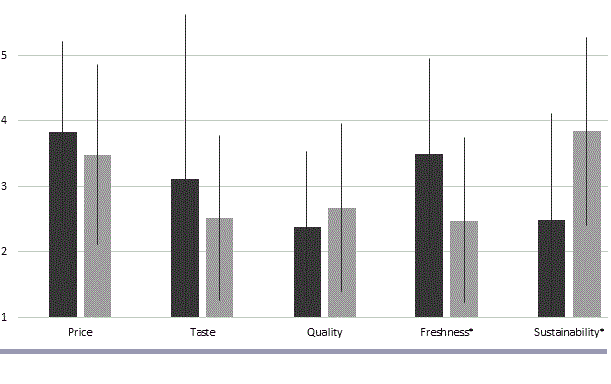
Fig. 3 . Ocean Wise versus non-Ocean Wise rank of factors when purchasing seafood.